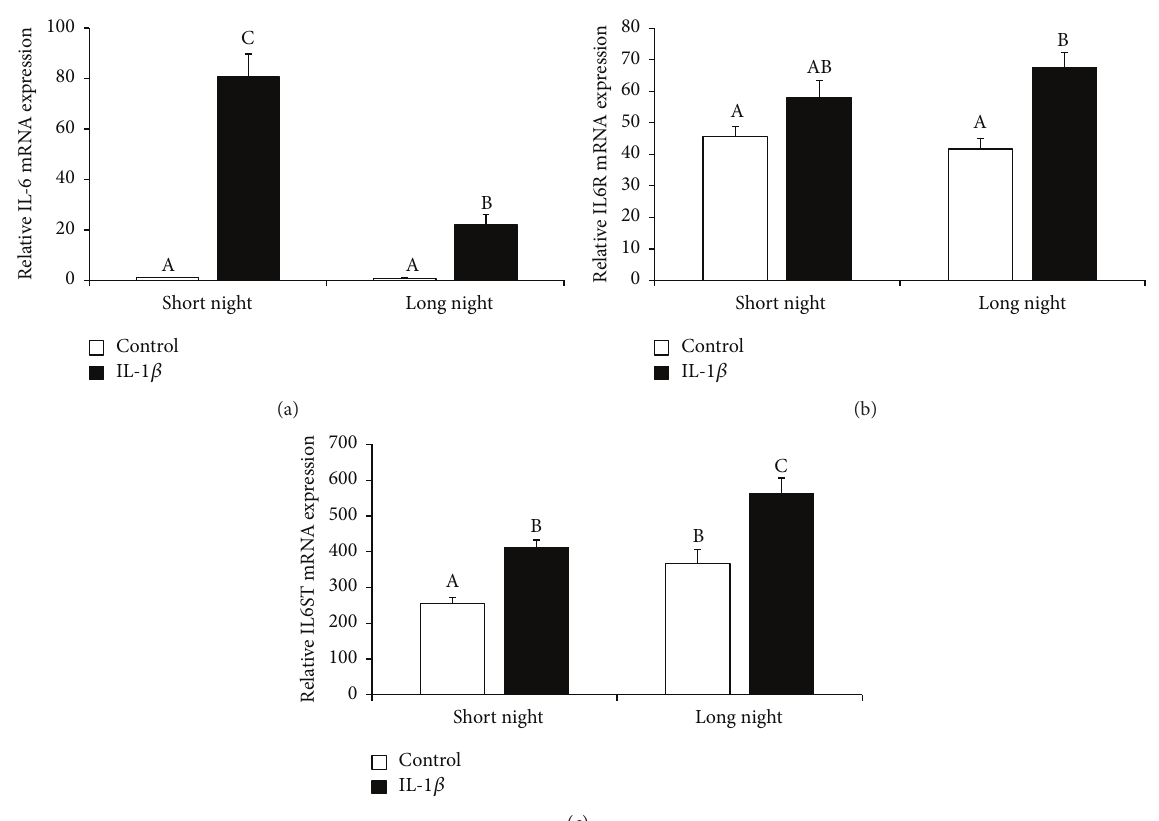
Figure 7: The effects of icv. injection of interleukin- (IL-) 1 𝛽 (50 𝜇 g/animal) or Ringer’s solution (50 𝜇 L) on the relative gene expression (mean ± SEM; 𝑛 = 6 animals per group) of IL-6 (a), interleukin 6 receptor (IL6R, (b)), and interleukin 6 signal transducer (IL6ST, (c)) in ewes during the short night (SN, May/June) and long night (LN, November/December) photoperiods. All data presented in the figure were normalised to the average relative level of IL-6 gene expression in the control ewes from the SN photoperiod, which was set to 1.0. Different capital letters indicate significant ( 𝑃 < 0.05 ) differences according to a two-way ANOVA followed by Tukey’s post hoc